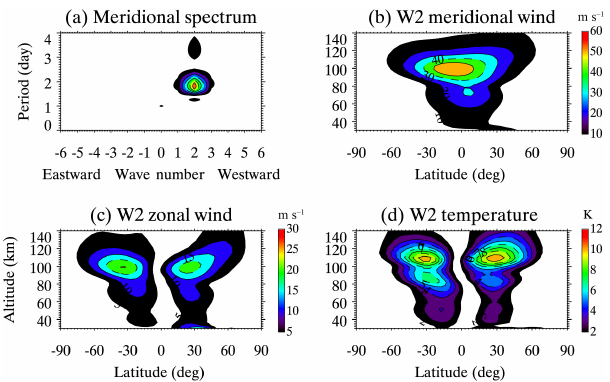
Figure 9. Similar to Fig. 5 but for case 3 during model days 15– 20. (a) shows the meridional wind spectrum at 100km and 2.5 ◦ N. (b) , (c) , and (d) show the global and vertical structures of W2 for meridional wind, zonal wind, and temperature, respectively.